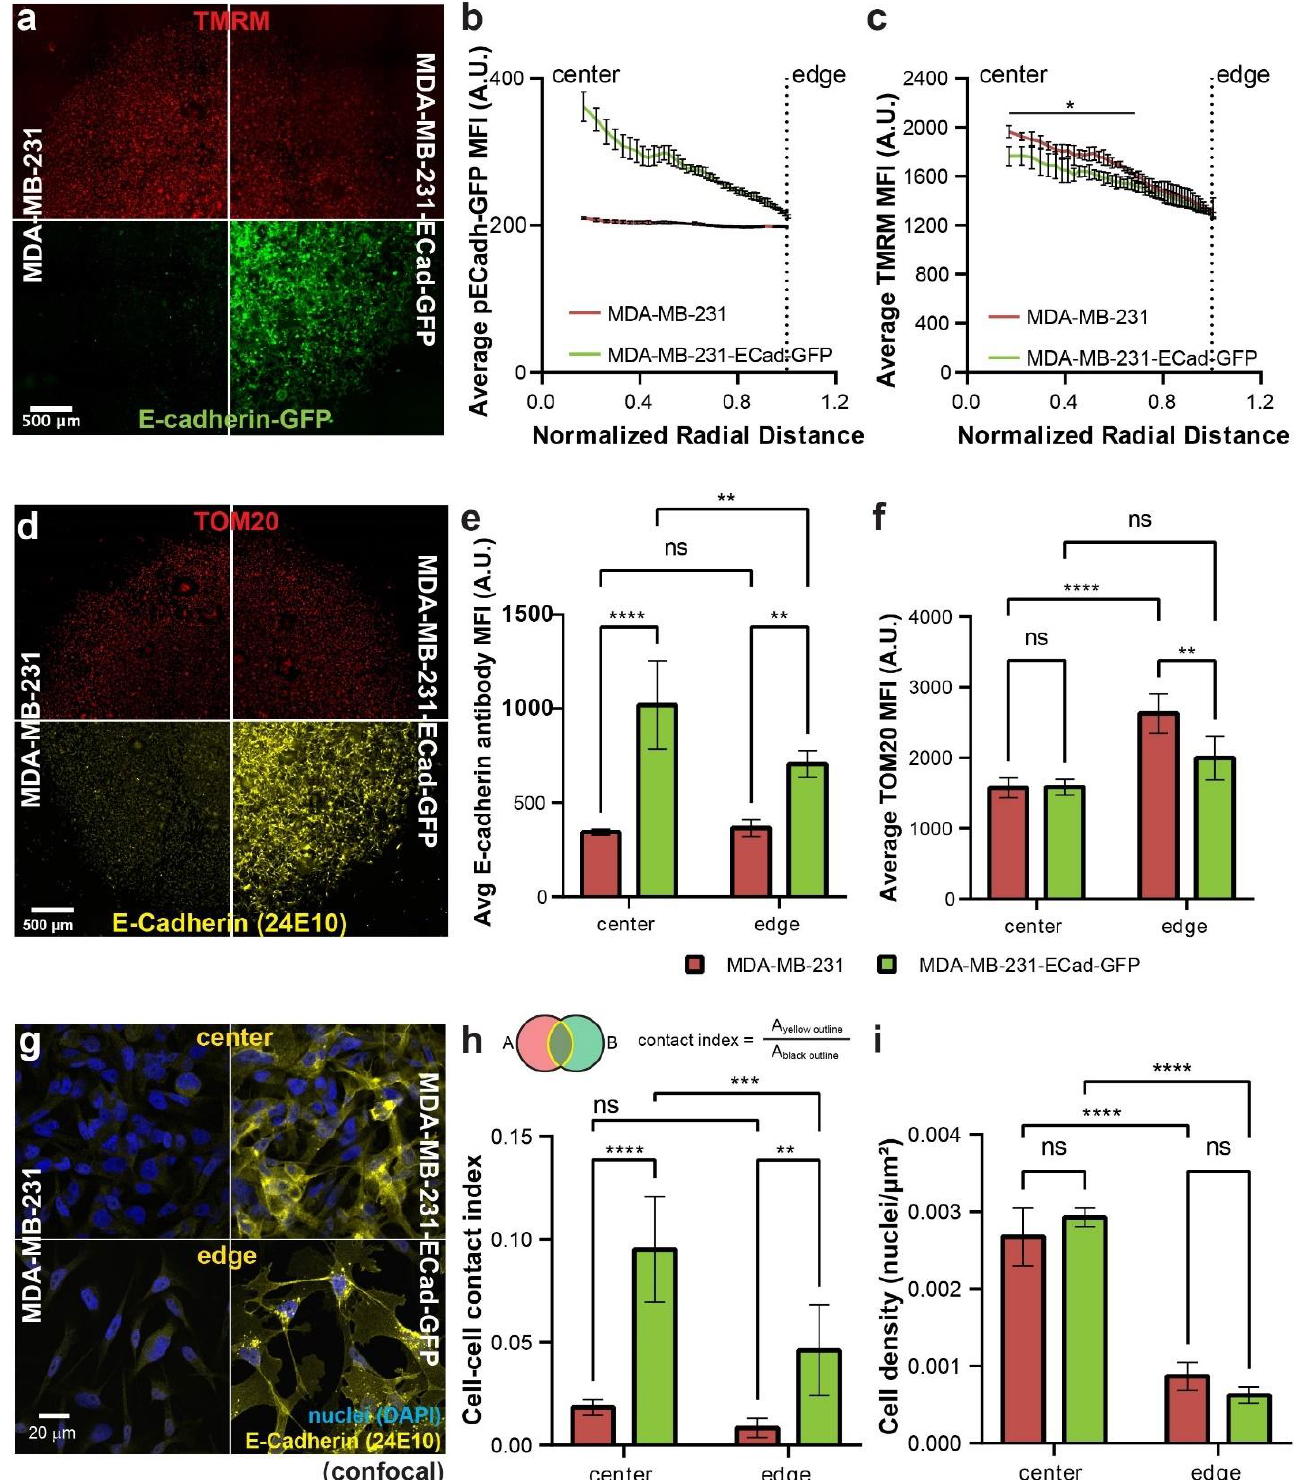
Figure 4. Effect of E-cadherin expression on the spatial distribution of ΔΨ m in MDA-MB-231 micropatterns. ( a ) TMRM and E-cadherin-GFP fluorescence of day 4 unconfined micropatterns of MDA-MB-231 (non-transfected control) and MDA-MB-231 cells transfected with E-cadherin-GFP (widefield imaging). ( b ) Radial distribution of E-cadherin-GFP in E-cadherin-GFP transfected vs. non-transfected micropatterns as shown in ( a ), n = 4 micropatterns per condition. ( c ) Radial distribution of ΔΨ m of representative micropatterns shown in ( a ), n = 4 micropatterns per condition. ( d ) Immunofluorescence widefield imaging showing TOM20 and E-cadherin antibody fluorescence in E-cadherin-GFP transfected vs. non-transfected controls. Quantification of mean fluorescence intensities of ( e ) E-cadherin and ( f ) TOM20 immunostaining at the centers and edges of the immunostained micropatterns shown in ( d ). ( g ) Confocal imaging showing E-cadherin